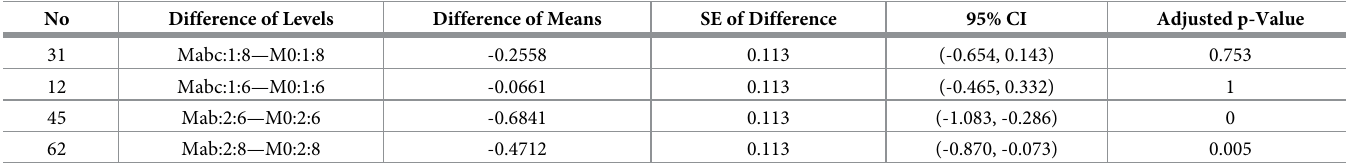
Table 12. Result of mean difference between each of the